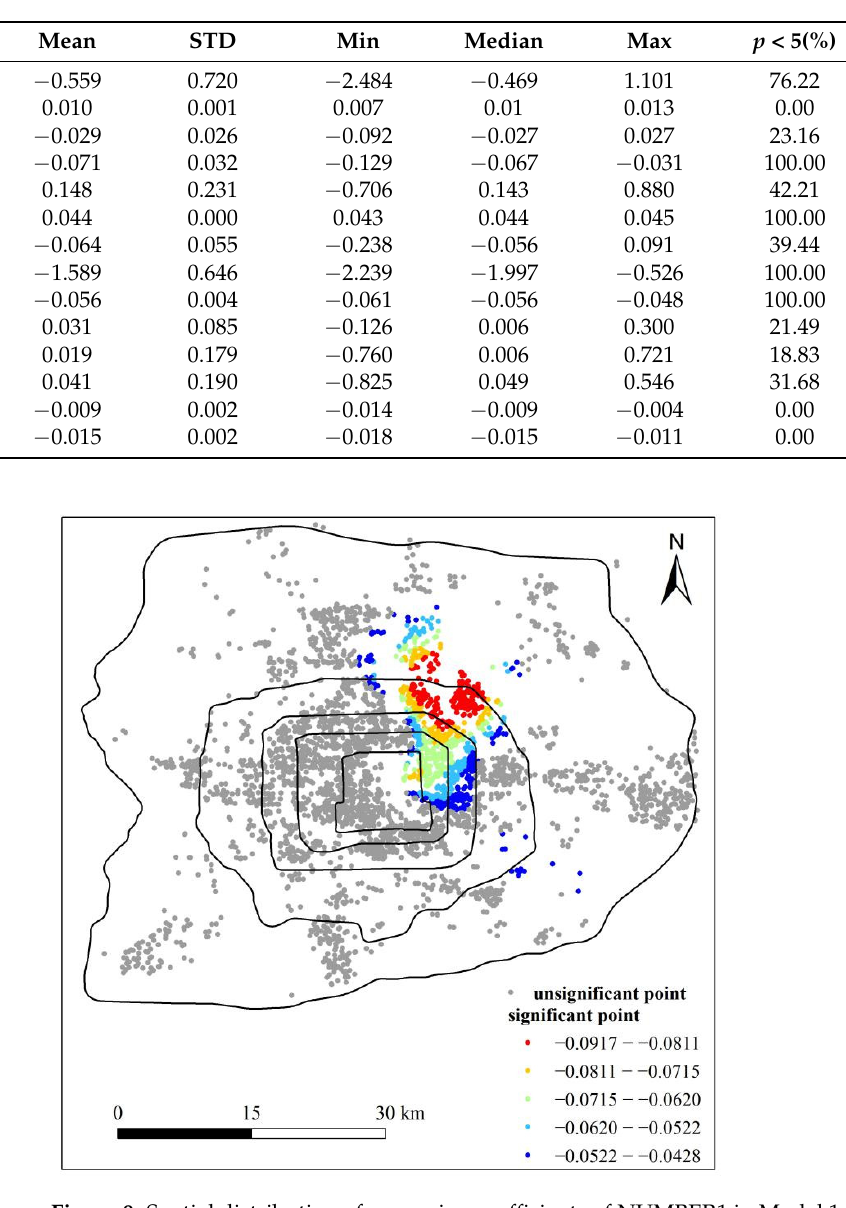
Table 5. MGWR model results of Model 2.